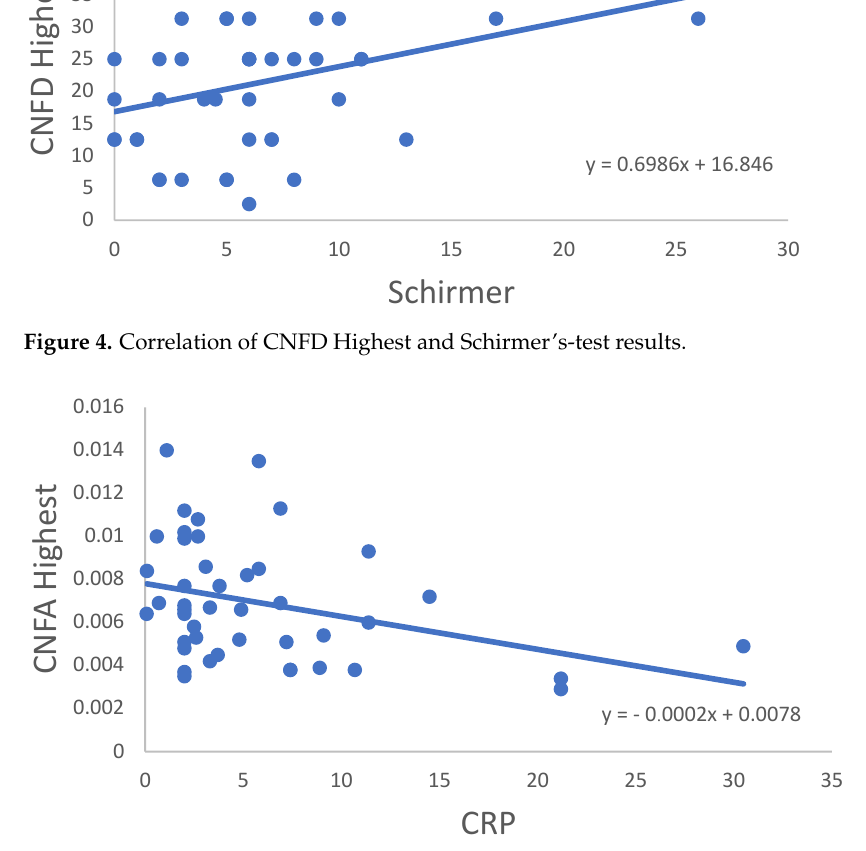
Figure 5. Correlation of CNFA Highest and CRP